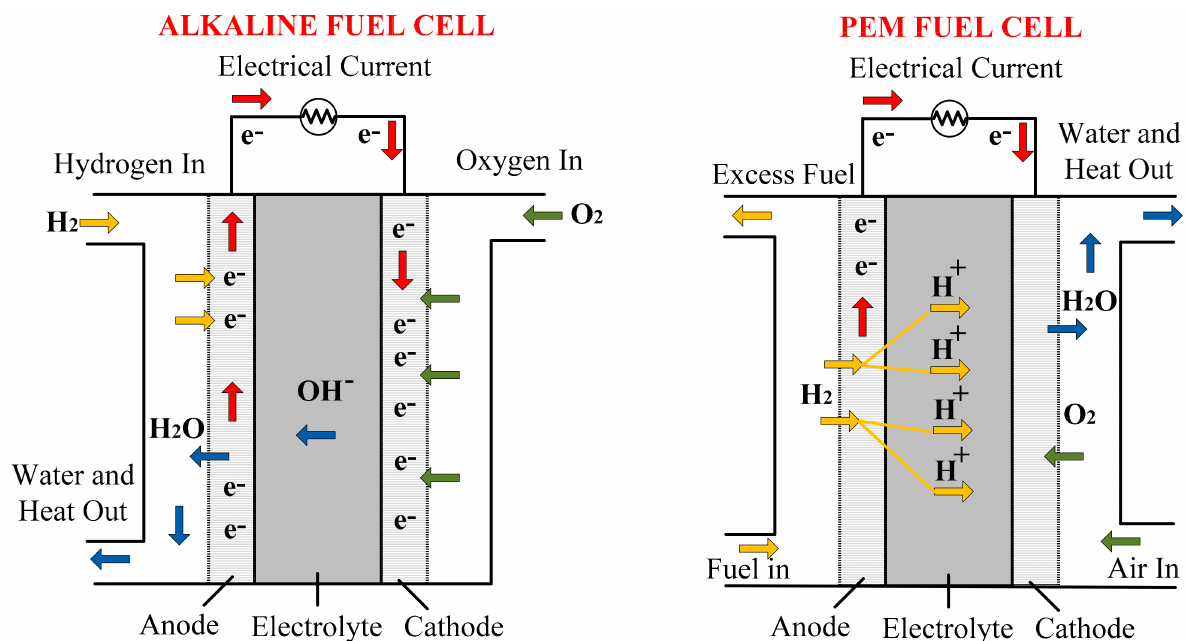
Figure 14. Alkaline fuel cell internal